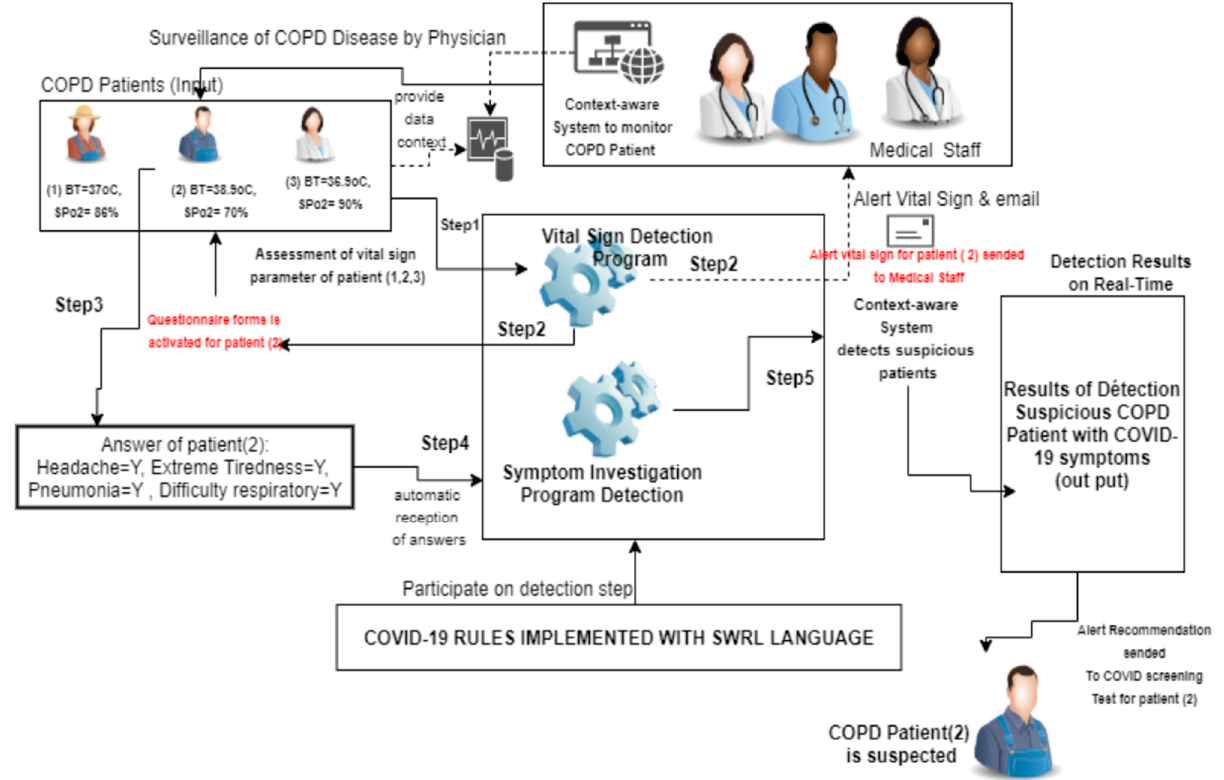
Figure 16. Detection process for a suspected COPD patient with COVID-19 symptoms.